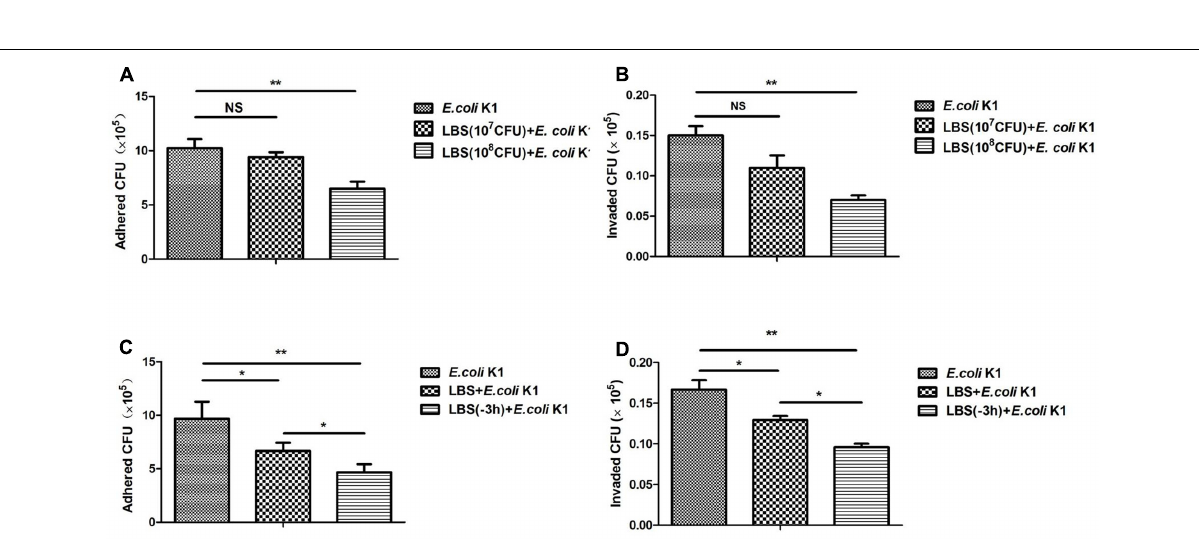
Frontiers in Microbiology |